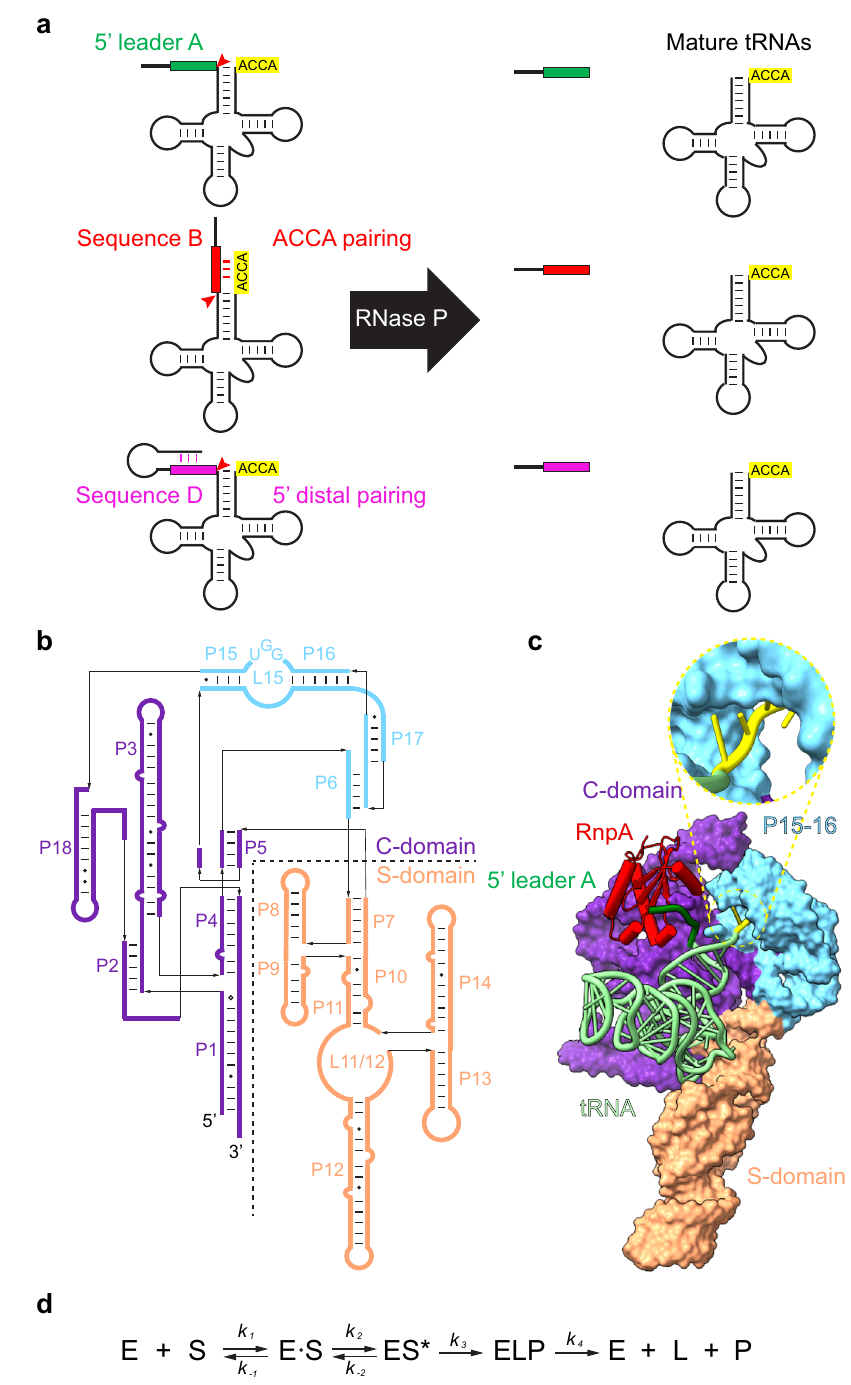
Fig. 1 | Structure and function of bacterial RNase P. a RNase P (black arrow) cleavesptRNAtoremove5 ′ leadersequencesandgeneratethematuretRNA(green, red, purple). The sequence of 5 ′ leaders are variable and are optimally single stran- ded (Sequence A) but can potentially form pairs with the 3 ′ RCCA (Sequence B) or fold back to form a stem-loop occluding the 5 ′ leader (Sequence B). b Secondary structure of T. maritima RNase P RNA. c Structure of T. maritima RNase P complex with product tRNA (PDB entry: 3Q1R) 10 . Zoom-in view for the positioning of the 3 ′